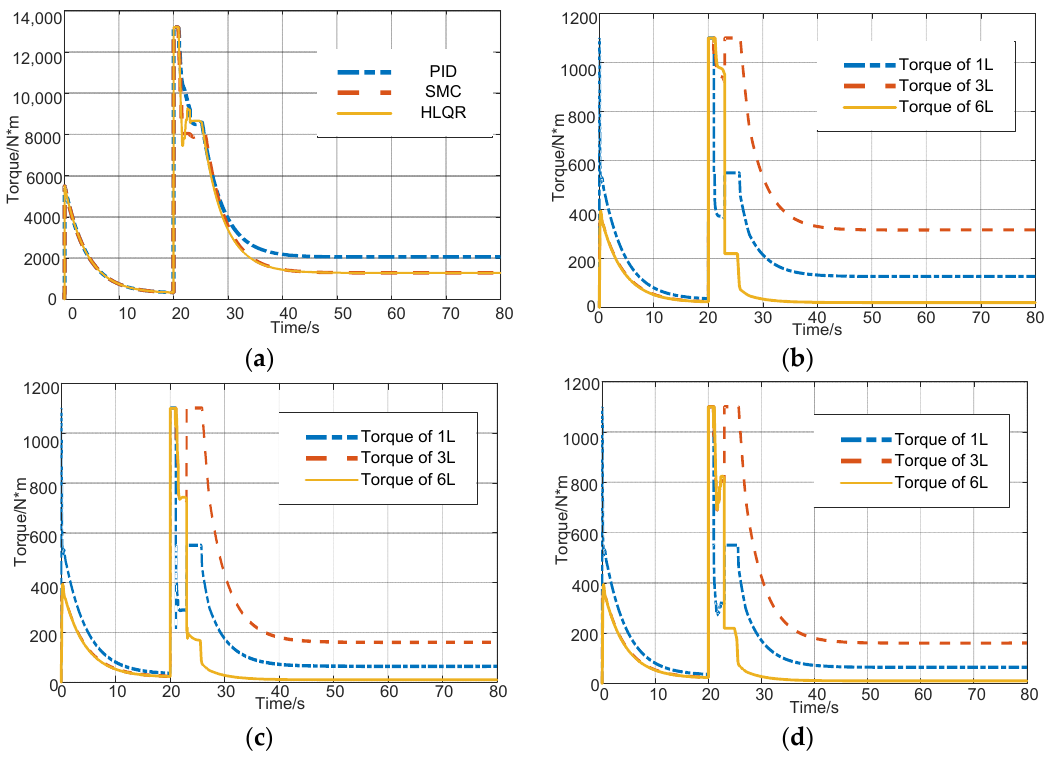
Figure 11. On the split road surface: ( a ) total driving torque; torque of left wheel for the 1st, 3rd; and 6th axles; ( b ) controlled by PID; ( c ) controlled by SMC; ( d ) controlled by HLQR. Under this working condition, the right wheel enters the low-adhesion road and may slip. The left motor partially fails, but the wheel does not slip because of the high adhesion coe ffi cient. Therefore, take the sliding wheel and the right wheel of axle 3 (3R) as examples to explain the e ff ectiveness of algorithms. The slip ratios of 3R controlled by PID, SMC, and HLQR are presented in Figure 12. It can be seen that the wheel on the right side of the 3rd axle is well controlled and approaches the reference value by the HLQR algorithm with a smaller deviation. The RMS of the slip ratio controlled by the PID is 0.1634; that controlled by the SMC is 0.1156; and that controlled by the HLQR is 0.0983. Compared with PID and SMC control methods, HLQR can improve the accuracy of slip ratio control by 39.8% and 14.9%, respectively.